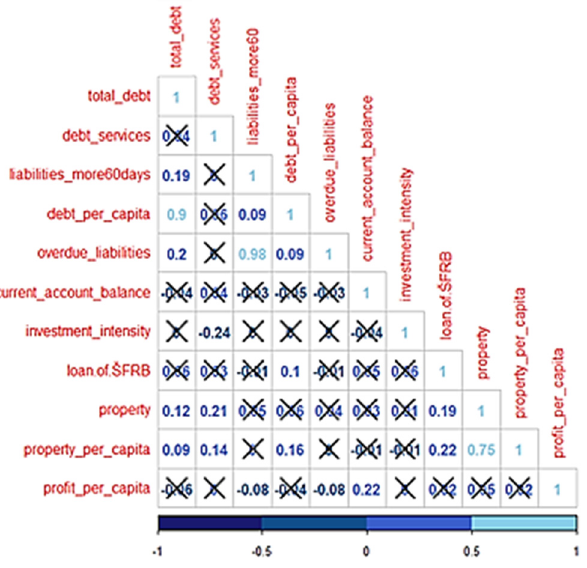
Figure 2. The marked dependence between variables. Source: own processing (R Studio).